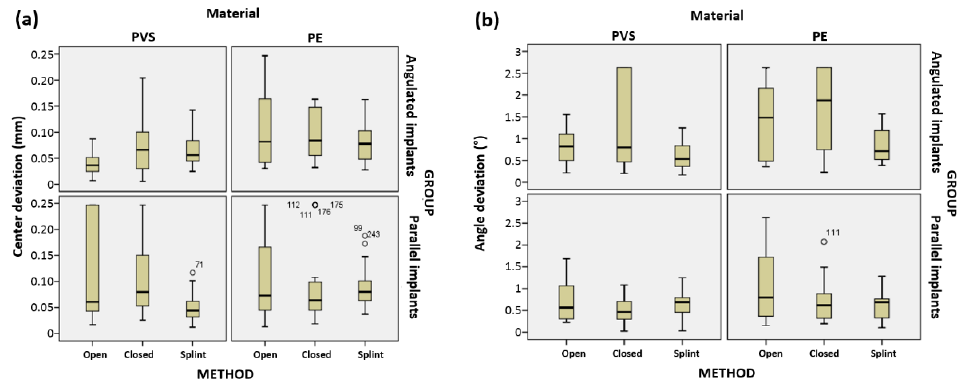
Figure 15. Graphical representation of the distribution of ( a ) the distance from the implant base center and ( b ) the angle of deviation.